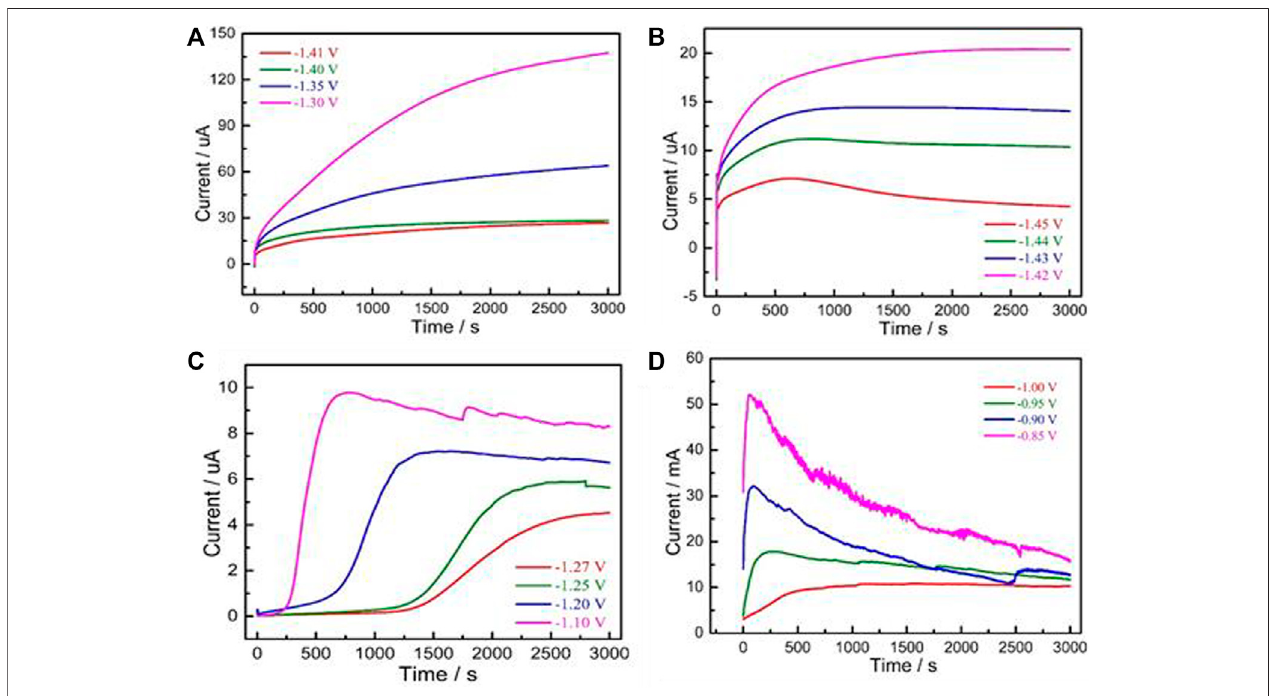
FIGURE 1 | I-T transient net current curves of Mg electrode: (A) − 1.30~ − 1.41 V; (B) − 1.42~ − 1.45 V; (C) − 1.10~ − 1.27 V; (D) − 0.85~ − 1.00 V.